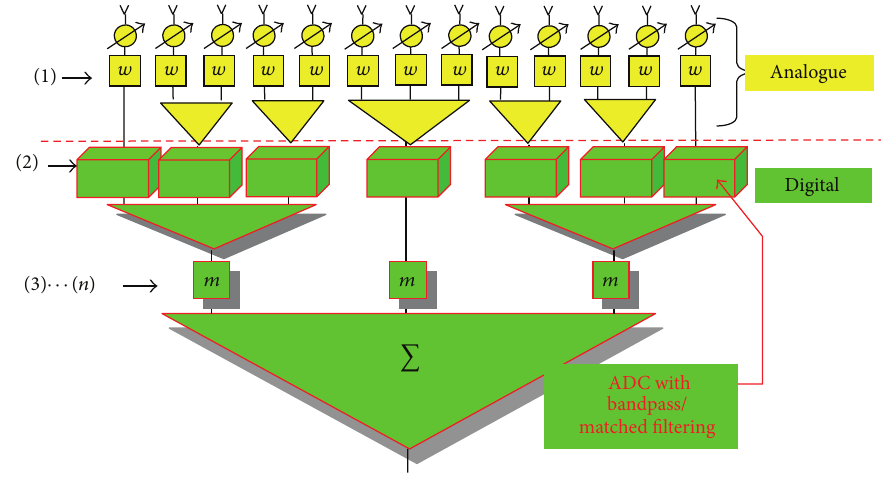
Figure 1: Principle of forming subarrays.